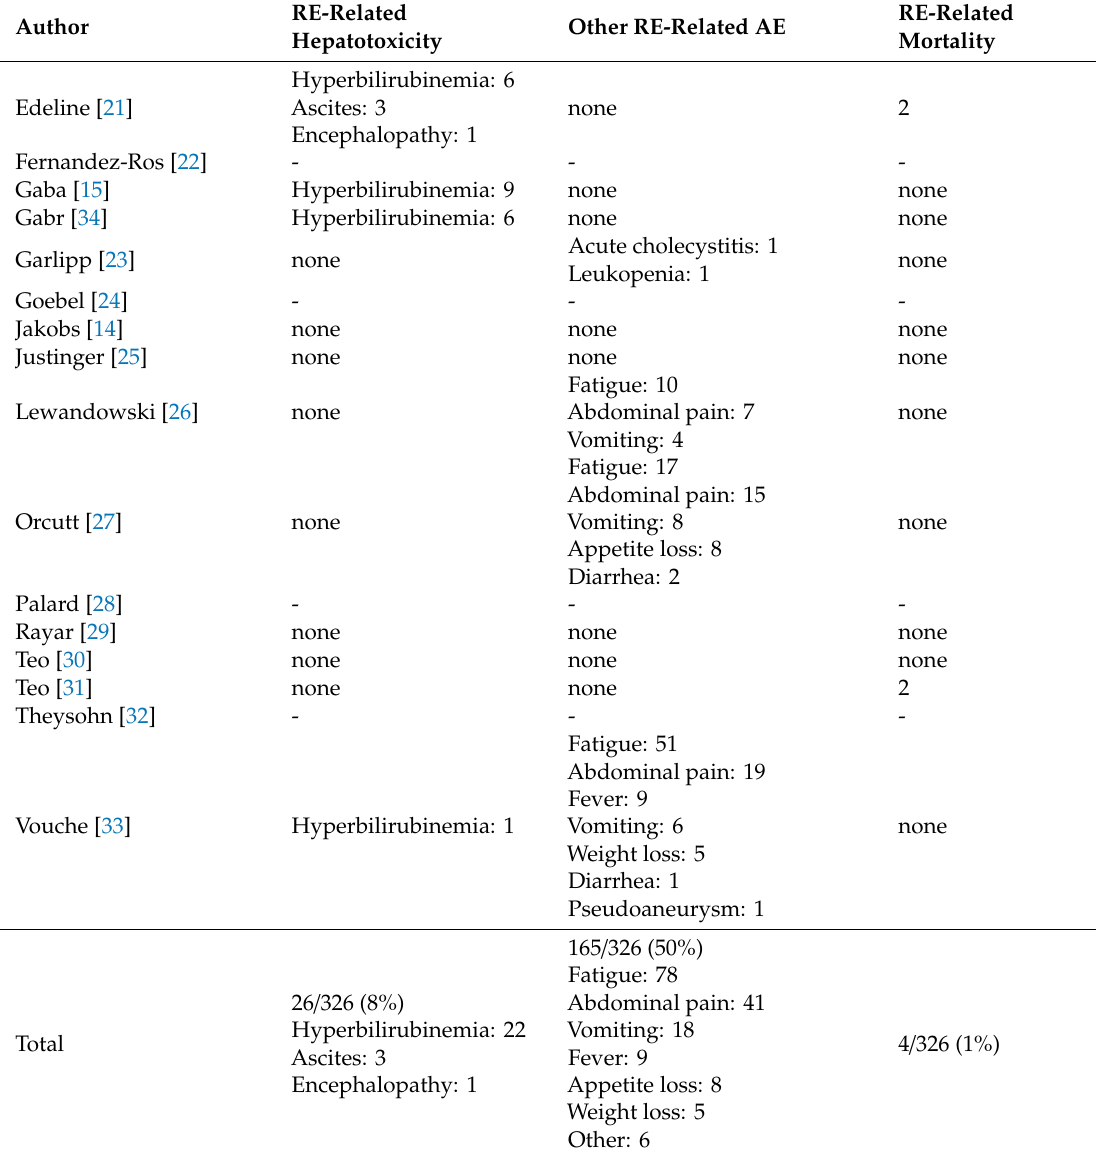
Table 4. Overview of complications and adverse e ff ects following